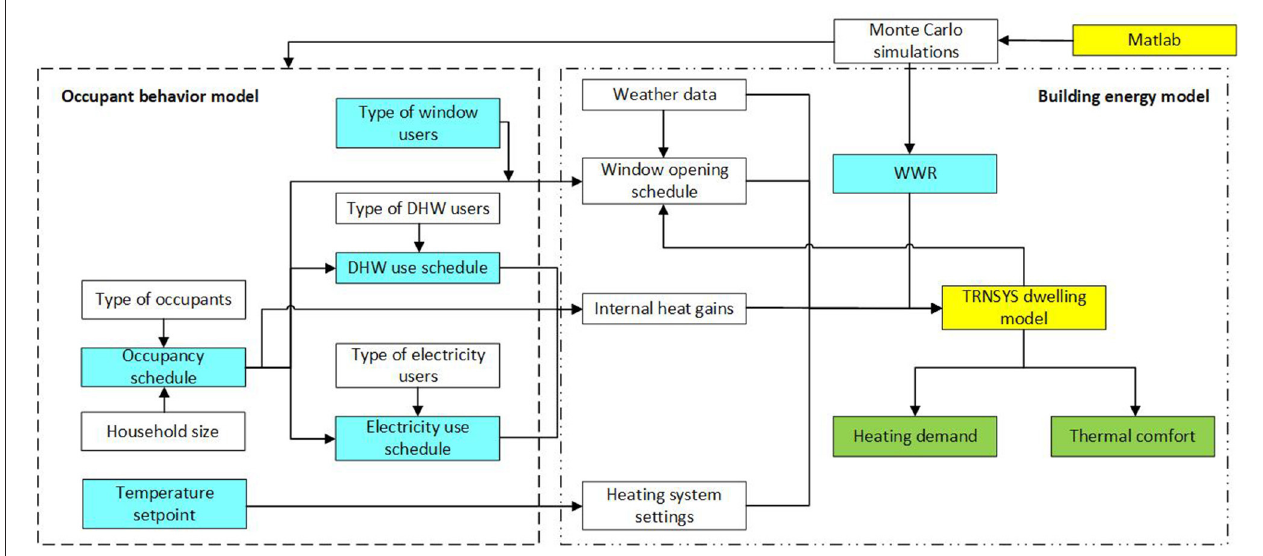
FIGURE 1 | Workflow diagram illustrating the procedure used in this work, including the occupant behavior model, the building energy model and the Monte Carlo approach.